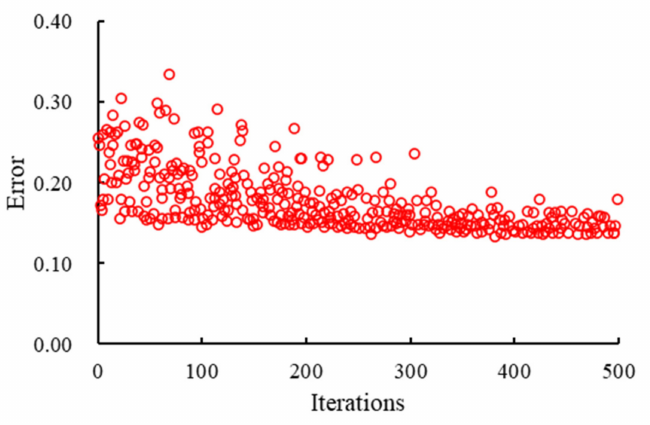
Figure 6. Calculation error vs. genetic